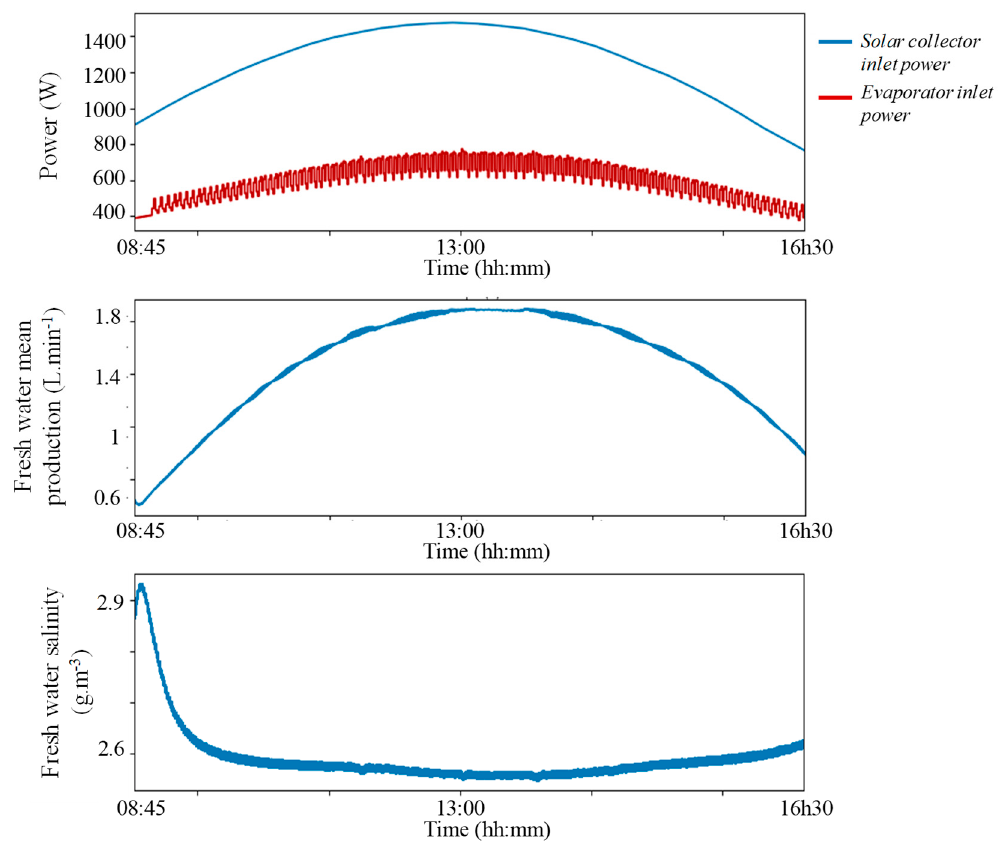
Figure 18. Simulated fresh-water production and quality over a sunny day.